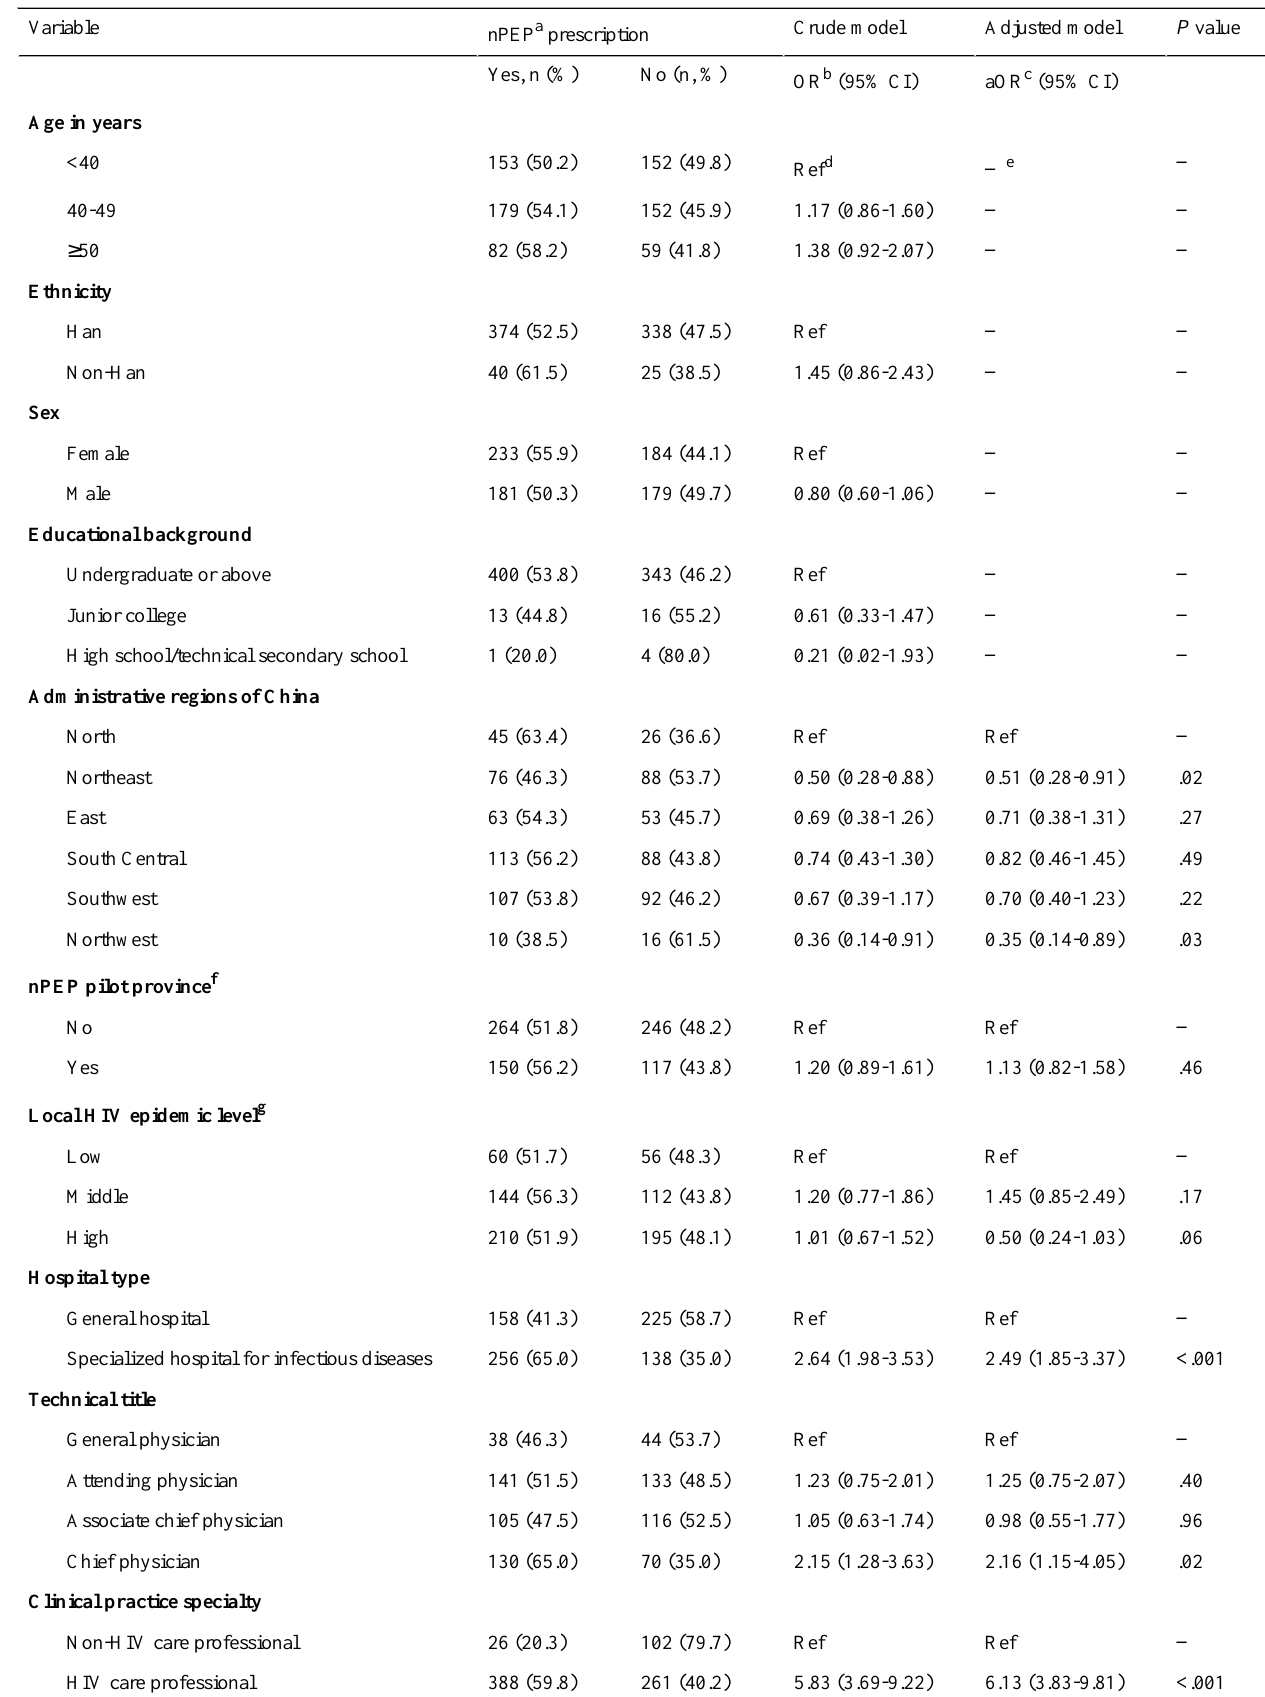
Table 3. Univariable and multivariable logistic regression analyses of associations of potential predictors and nPEP prescription history among HIV medical care providers in China